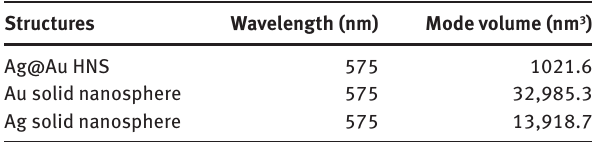
Table 1: LSP mode volumes of an HNS and solid Au and Ag nanoparticles at 575